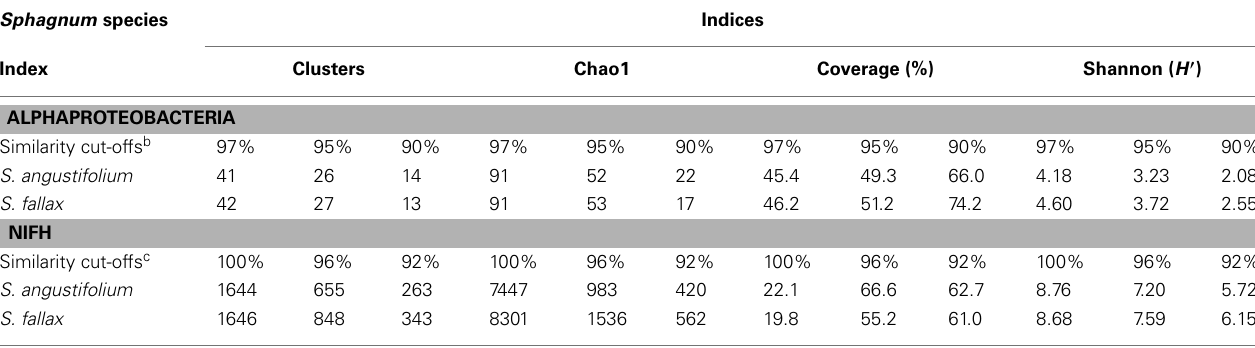
Table 1 | Richness estimates and diversity indices for amplicon libraries of Sphagnum samples a .